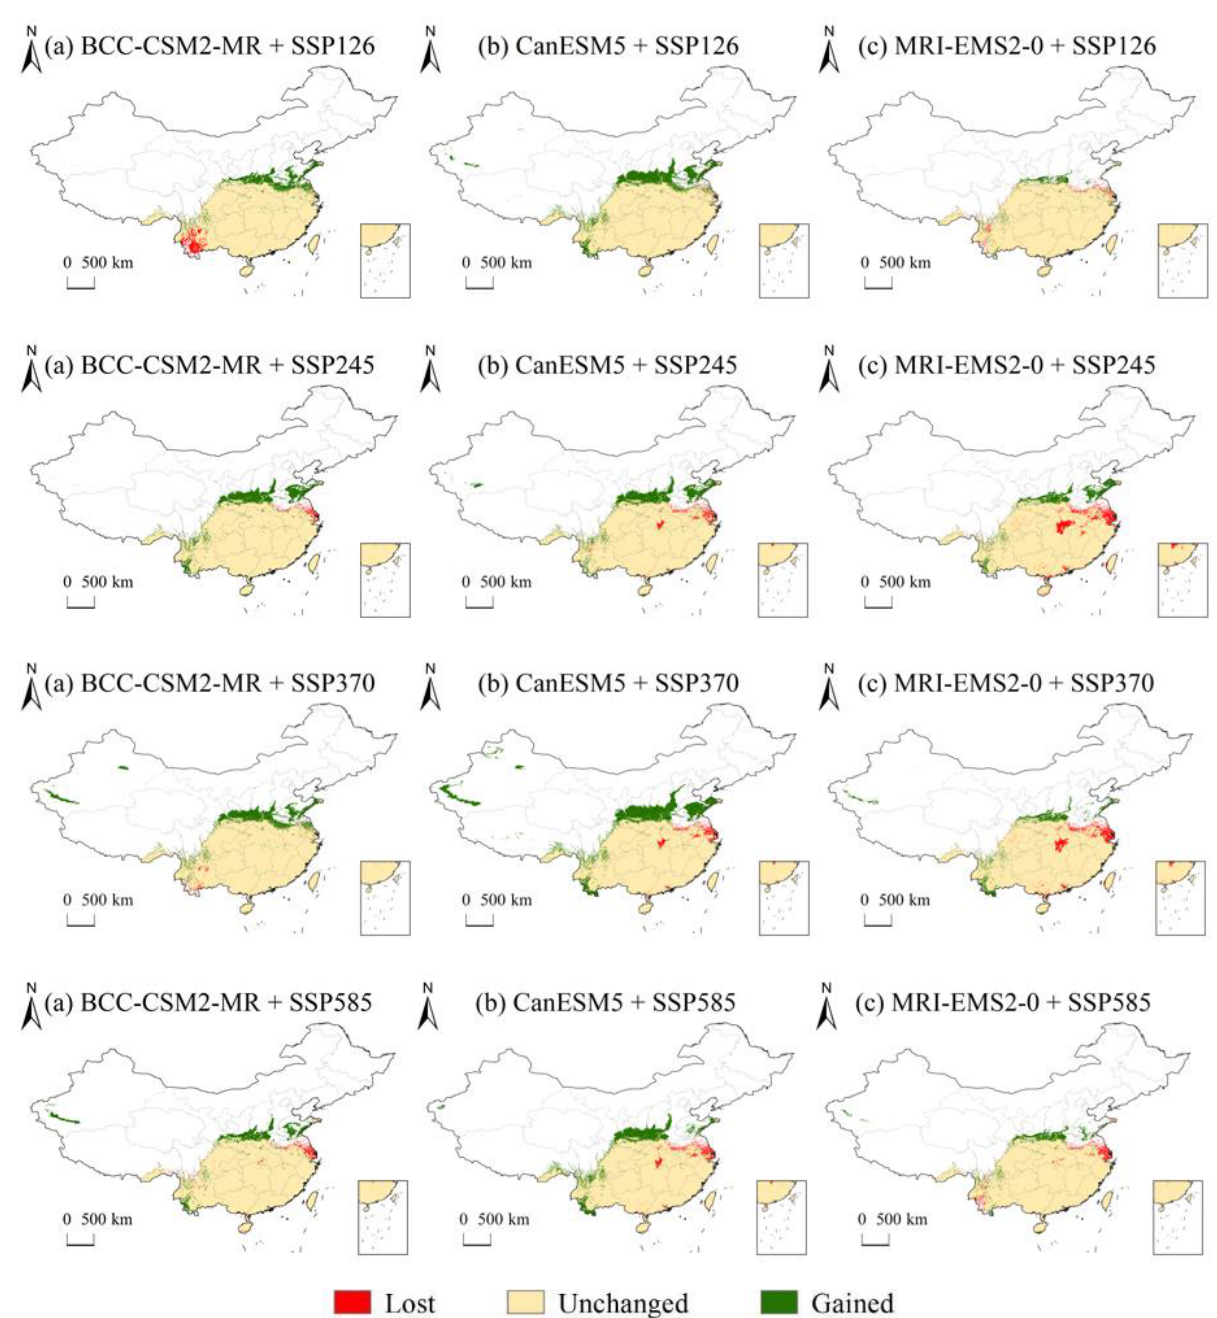
Figure 7. Changes in the potential geographical distribution of C. lanceolata in the models under the different scenarios.